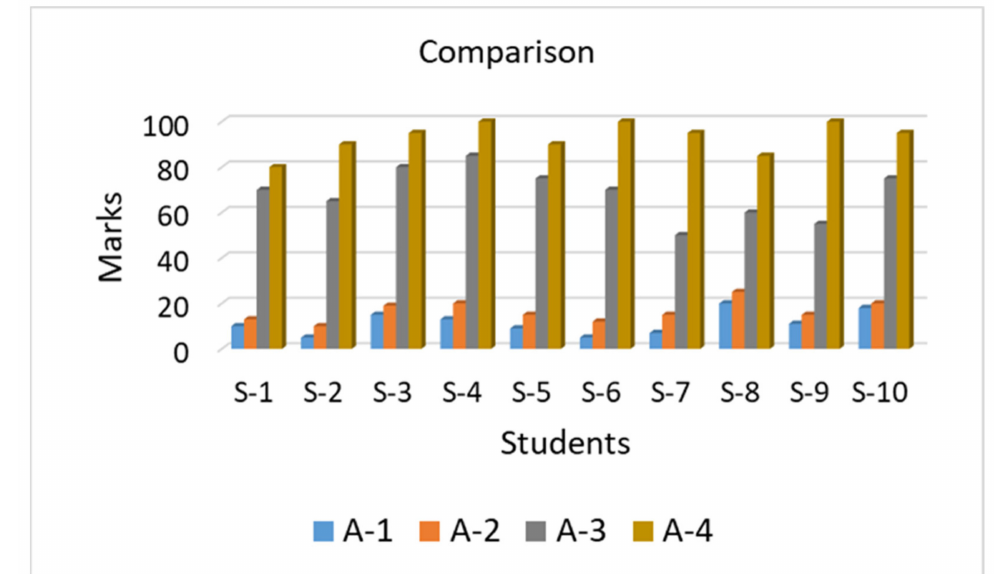
Figure 13. Results comparison of different activities